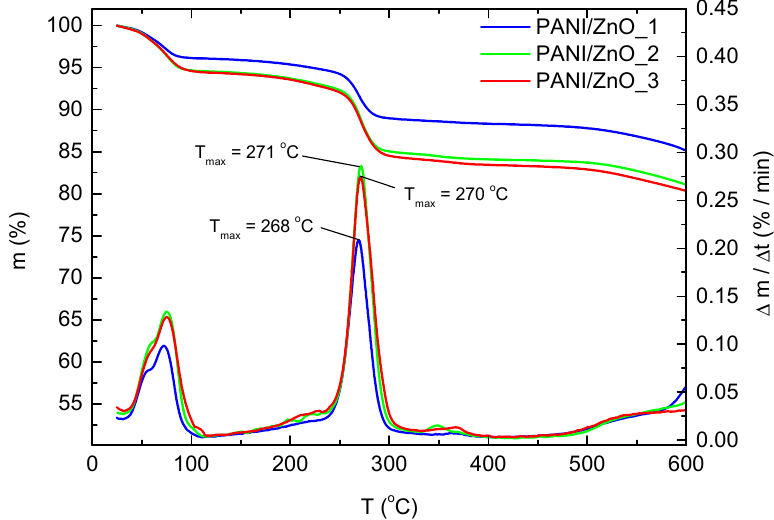
Figure 3. Thermogravimetric (TG) and accompanied derivative thermogravimetric (DTG) data obtained by investigation of synthesized PANI / ZnO photocatalysts. Table 3. Portion of ZnO and organic matter (aniline oligomers and PANI) in synthesized PANI / ZnO photocatalysts.